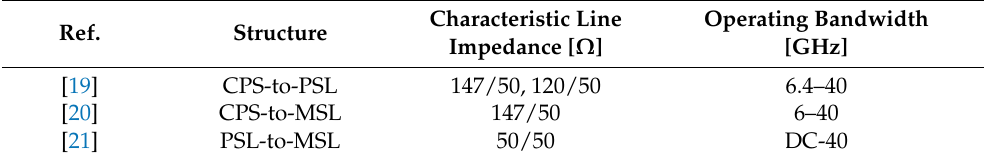
Table 1. Comparison of the ultra-wideband transitions. Ref.